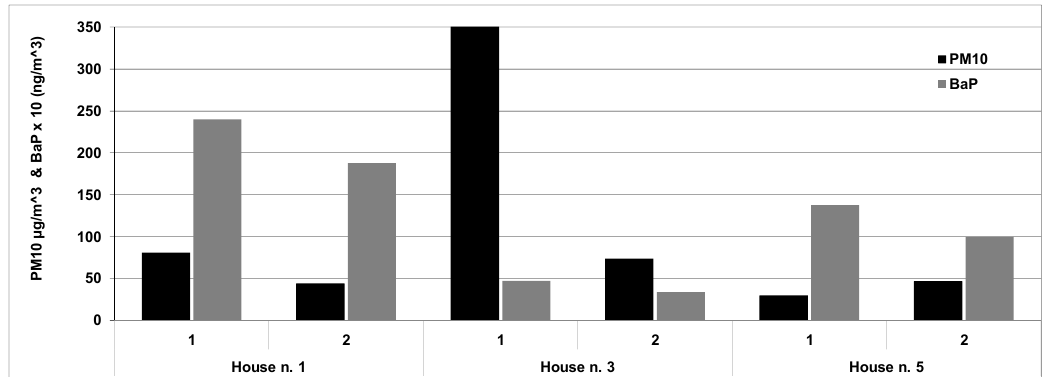
Figure 2. PM 10 and BaP concentrations for each lighting in three houses.